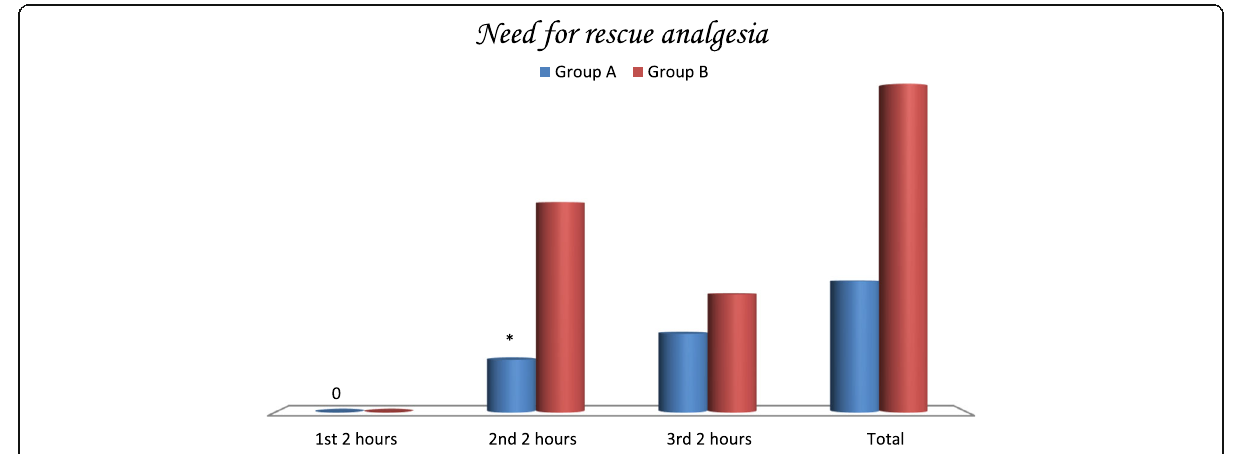
Fig. 2 Need for rescue analgesia in both groups. Data were expressed as count. * P < 0.05